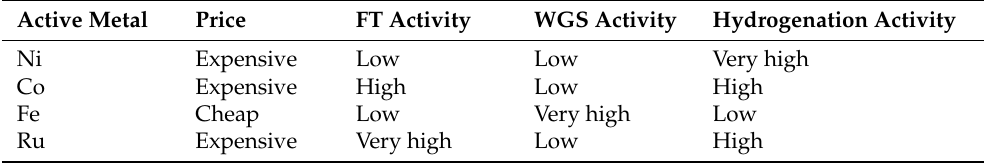
Table 4. Overview of main characteristics of Ni-, Fe-, Co- and Ru-based catalysts [76]. Active Metal Price FT Activity WGS Activity Hydrogenation Activity Ni Expensive Low Low Very high Co Expensive High Low High Fe Cheap Low Very high Low Ru Expensive Very high Low